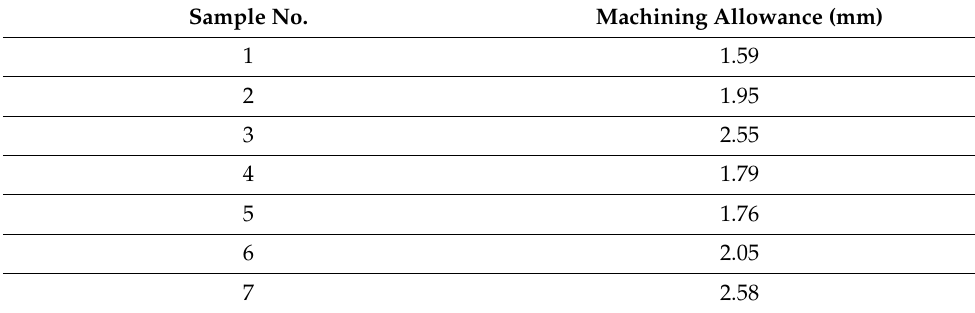
Table 5. Experimental settings used for